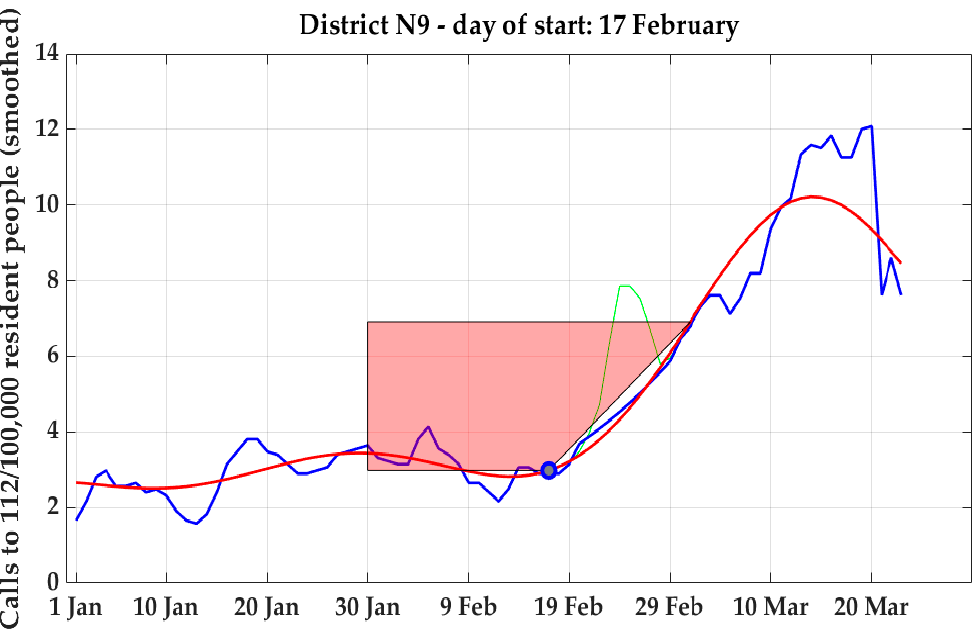
Figure 8. Example of the time-series of the normalized number of emergency calls to 112 (N / 100,000 resident people) from 1 January to 23 March 2020 in a specific cluster (i.e., #9). In blue, the time series after exponential fitting between x1 = 24 February 2020 and x2 = 29 February 2020, where the green line represents the portion of the original signal, characterized by a first peak, that needed to be filtered out (see text for details); the red line represents its low-pass filtered version, from which the fiducial points for the generation of the trapezium ABCD were derived and the inflection point (blue dot) detected.